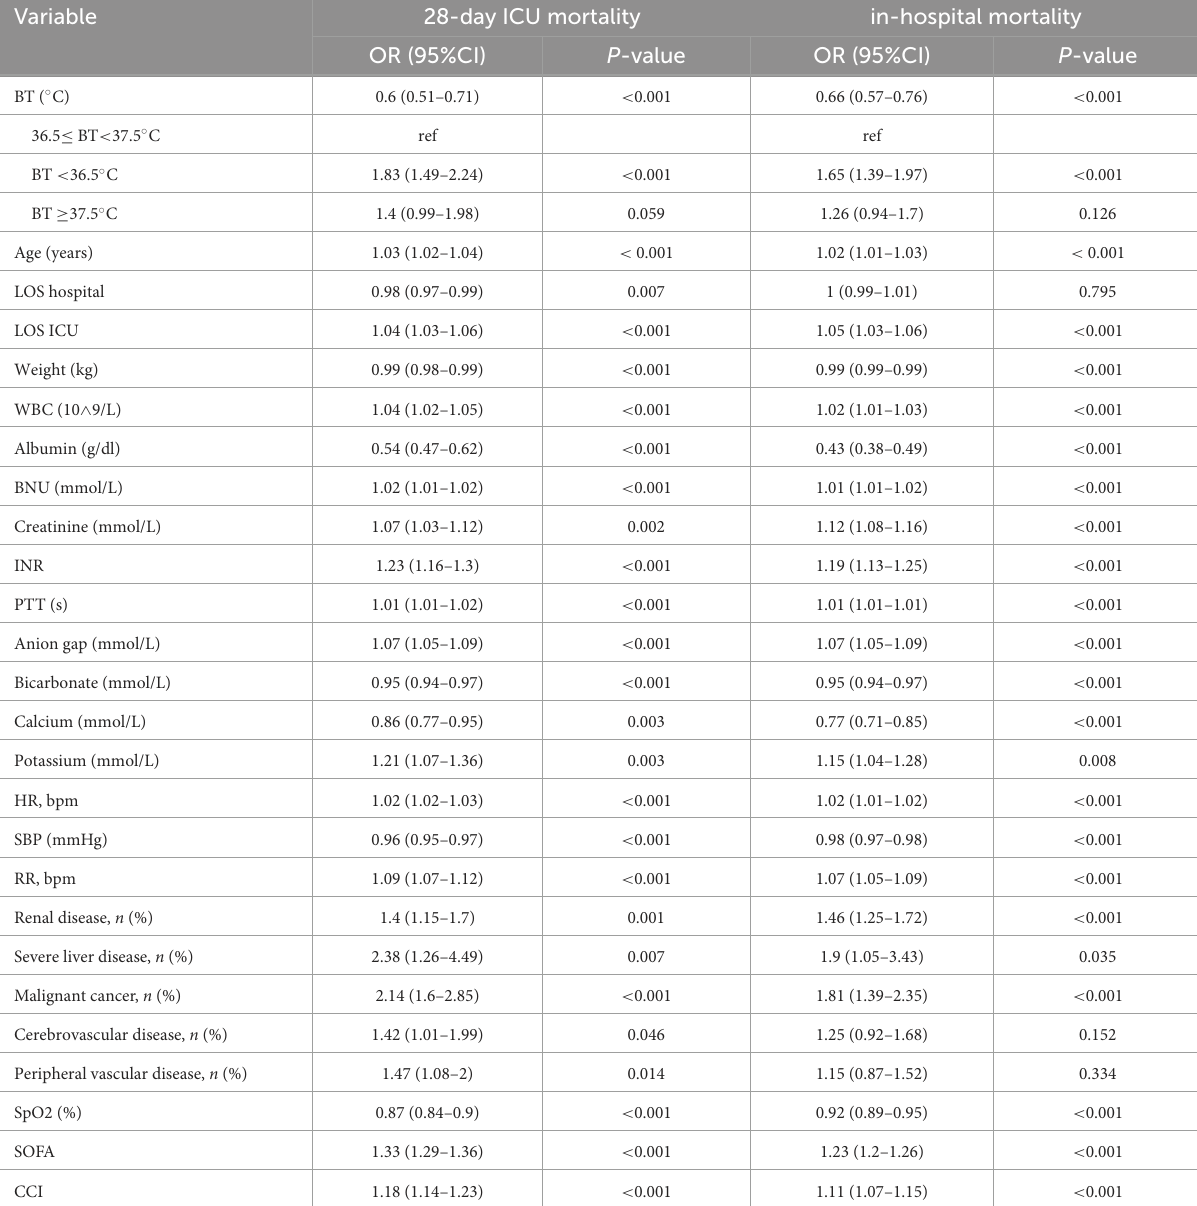
TABLE 2 Results of univariate analysis of 28-day ICU mortality and in-hospital